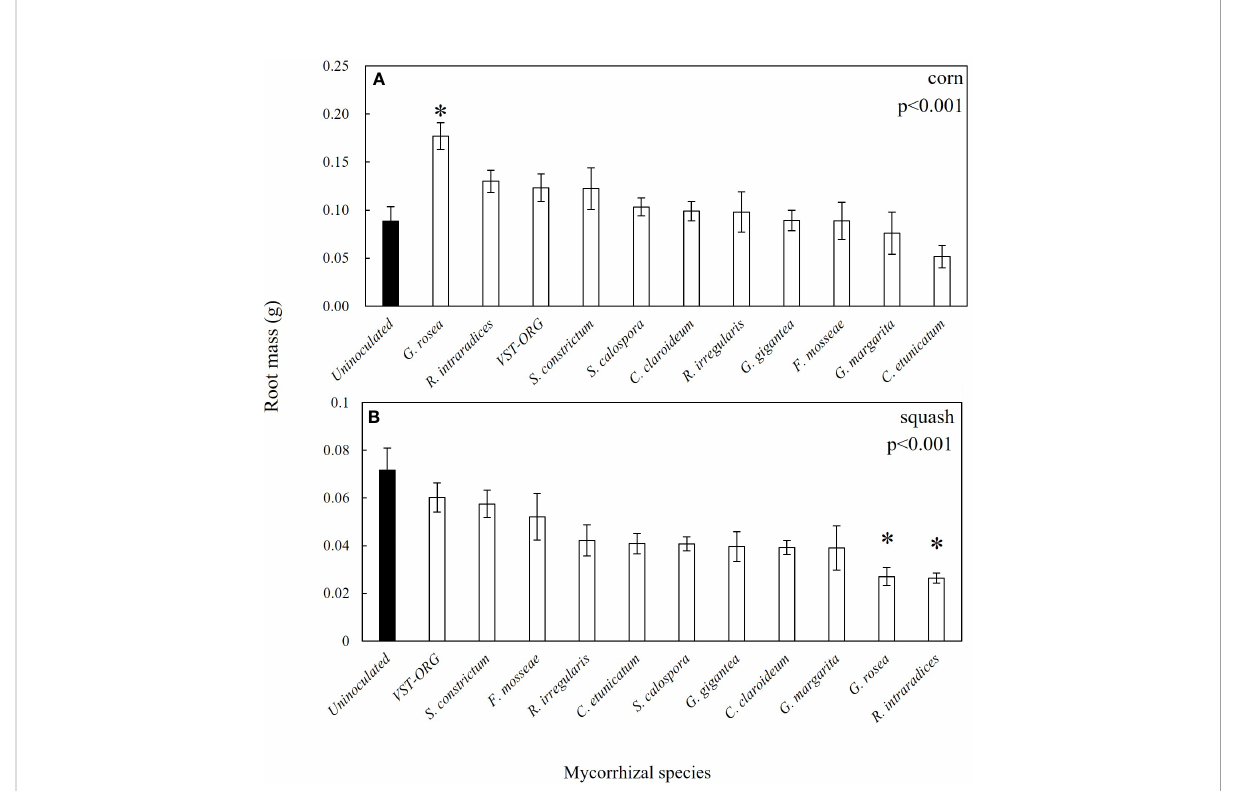
FIGURE 6 Root biomass of uninoculated and AMF inoculated corn (A) and squash (B) seedlings 30 days post germination. Most AMF inoculated squash seedlings had less root biomass than the uninoculated seedlings. The closed bars are uninoculated seedlings and the open bars are inoculated seedlings. P values are from the Kruskall Wallace H test. Asterisks represent signi fi cant differences between uninoculated seedlings and inoculated